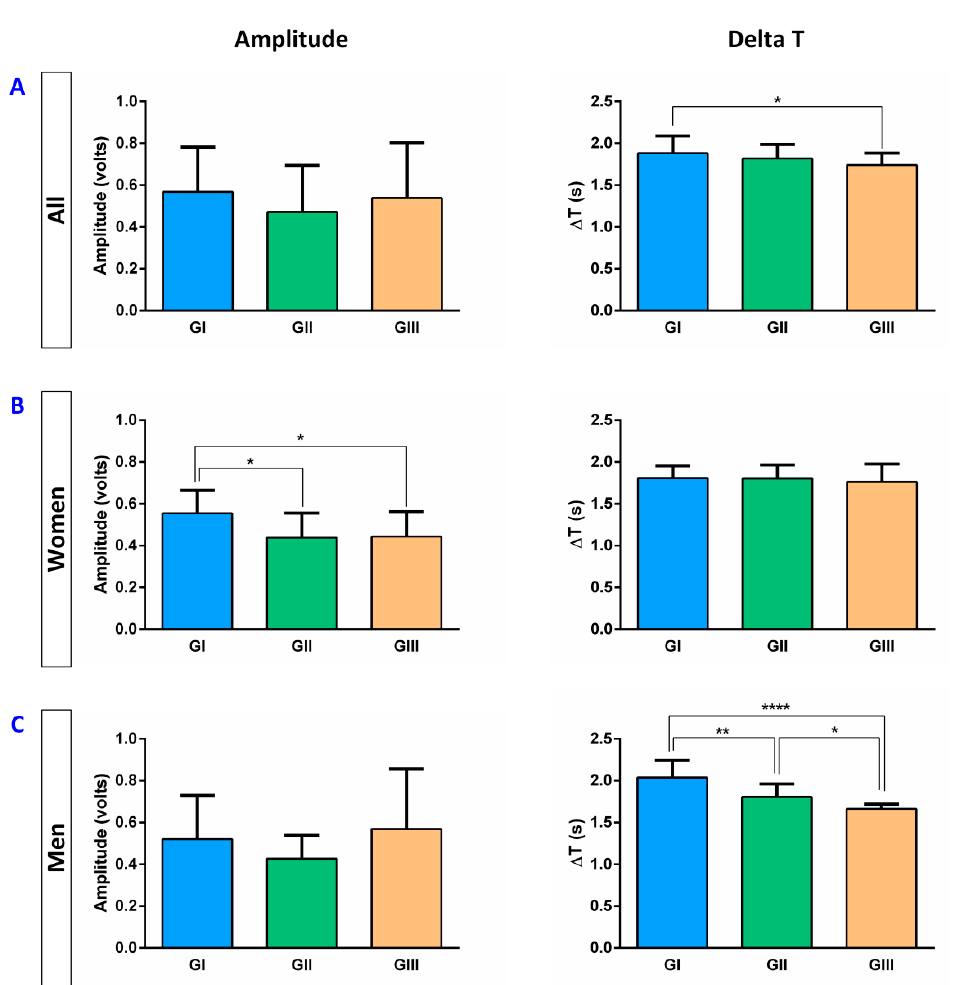
Figure 4. EMG metrics (Amplitude and Delta T) in all HV ( A ), women ( B ), and men ( C ). ∆ T: Delta T; s: seconds; GI: 18–39 years group; GII: 40–59 years group; GIII: ≥ 60 years group; * p < 0.05; ** p < 0.01; **** p < 0.0001.